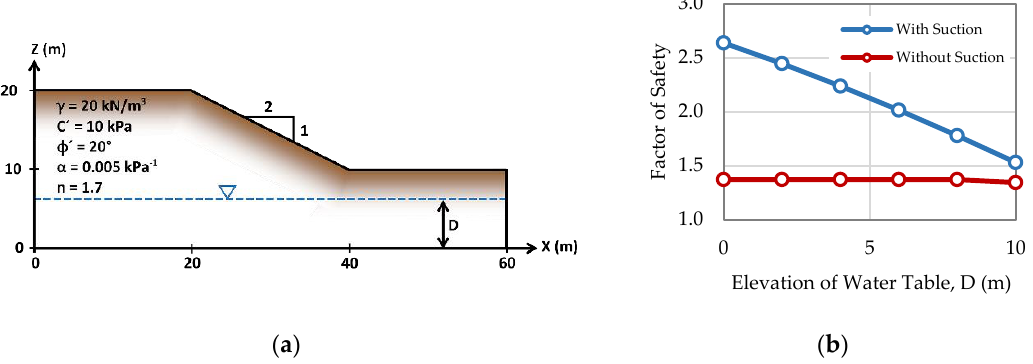
Figure 15. ( a ) The geometry of the slope, and ( b ) safety factor (SF) for different elevations of the water table.